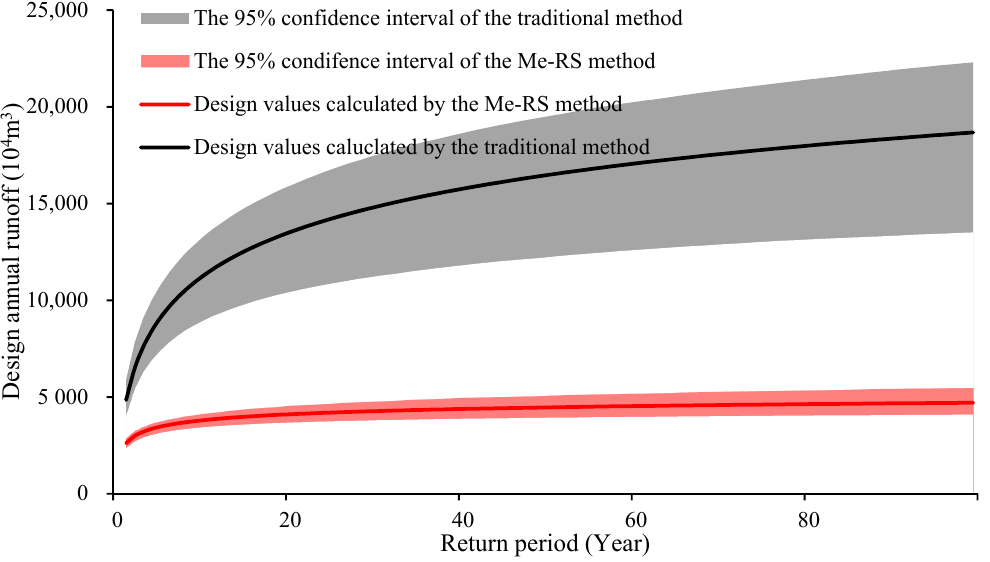
Figure 10. The design values of different return periods of the Me-RS series in JRB with the 95% bootstrapped confidence intervals.